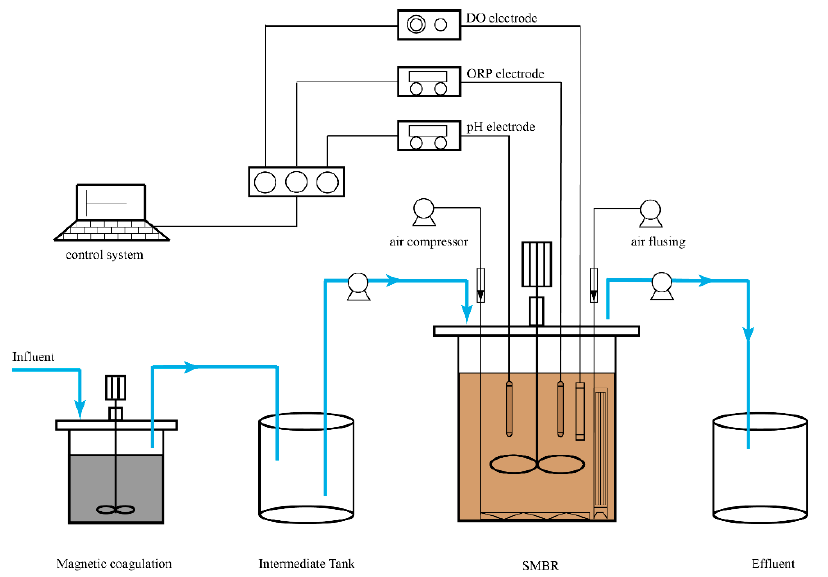
Figure 1. Setup of the combined magnetic coagulation and the sequence batch membrane bioreactor (SMBR).